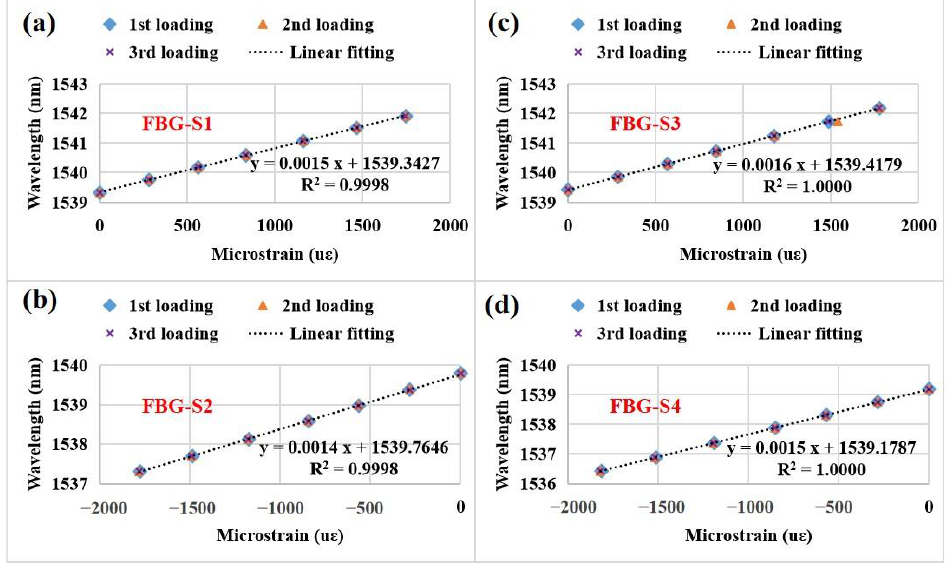
Figure 12. Central wavelengths of the four FBG strain sensors as a function of microstrains during